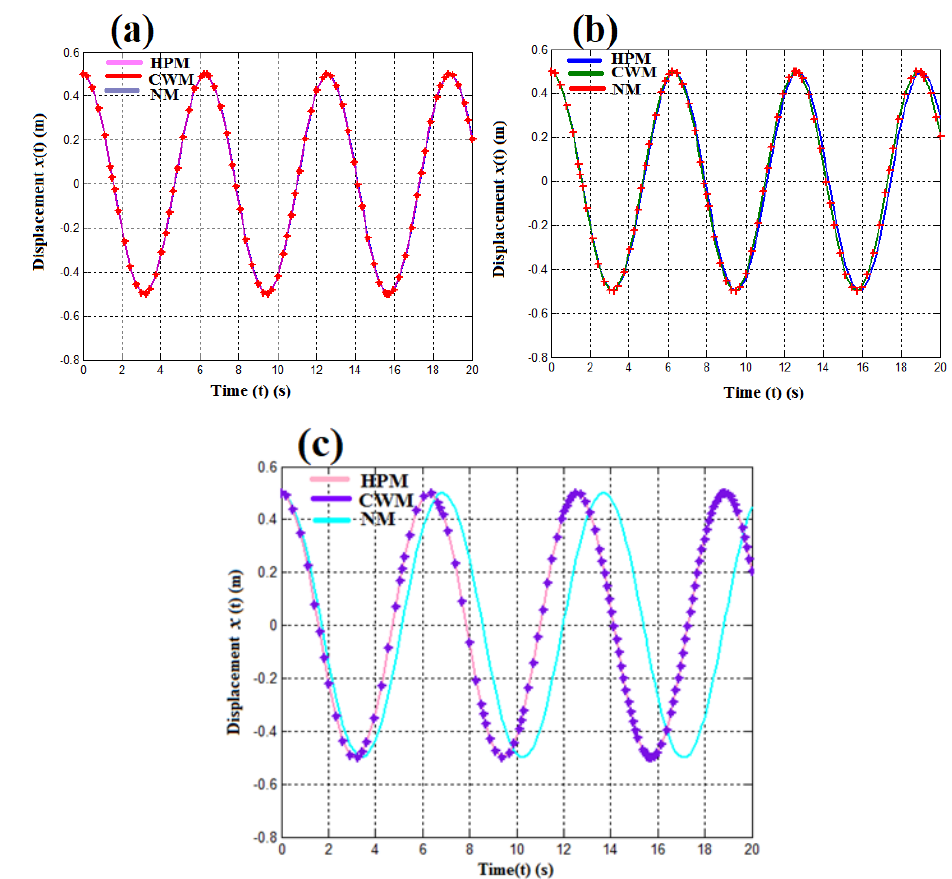
Fig. 1 (a–c) Comparison of CWM (Eq.(24), HPM (Eq.(25) and numerical method (MATLAB result) for various parameter values. Fig.1(a) l = 0 . 5 and µ = 0 . 01 Fig.1(b) l = 0 . 5 and µ = 0 . 1 Fig.1(c) l = 0 . 5 and µ = 1 .